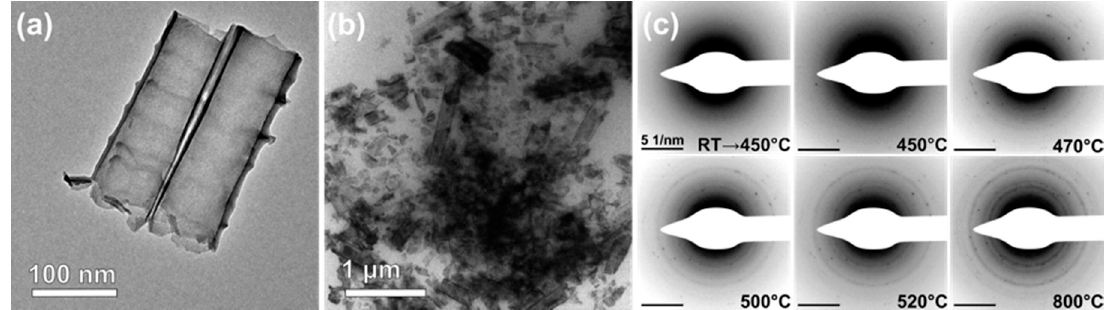
Figure 1. In situ selected area electron diffraction (SAED) heating experiment: ( a ) Representative (TiO2 amorphous nanotubes) TANs at room temperature RT; ( b ) The several micron-sized aggregate of TiO 2 TANs chosen for the in situ heating; ( c ) SAED patterns of the aggregate reported in panel ( b ), recorded at different temperatures during the in situ heating experiment.